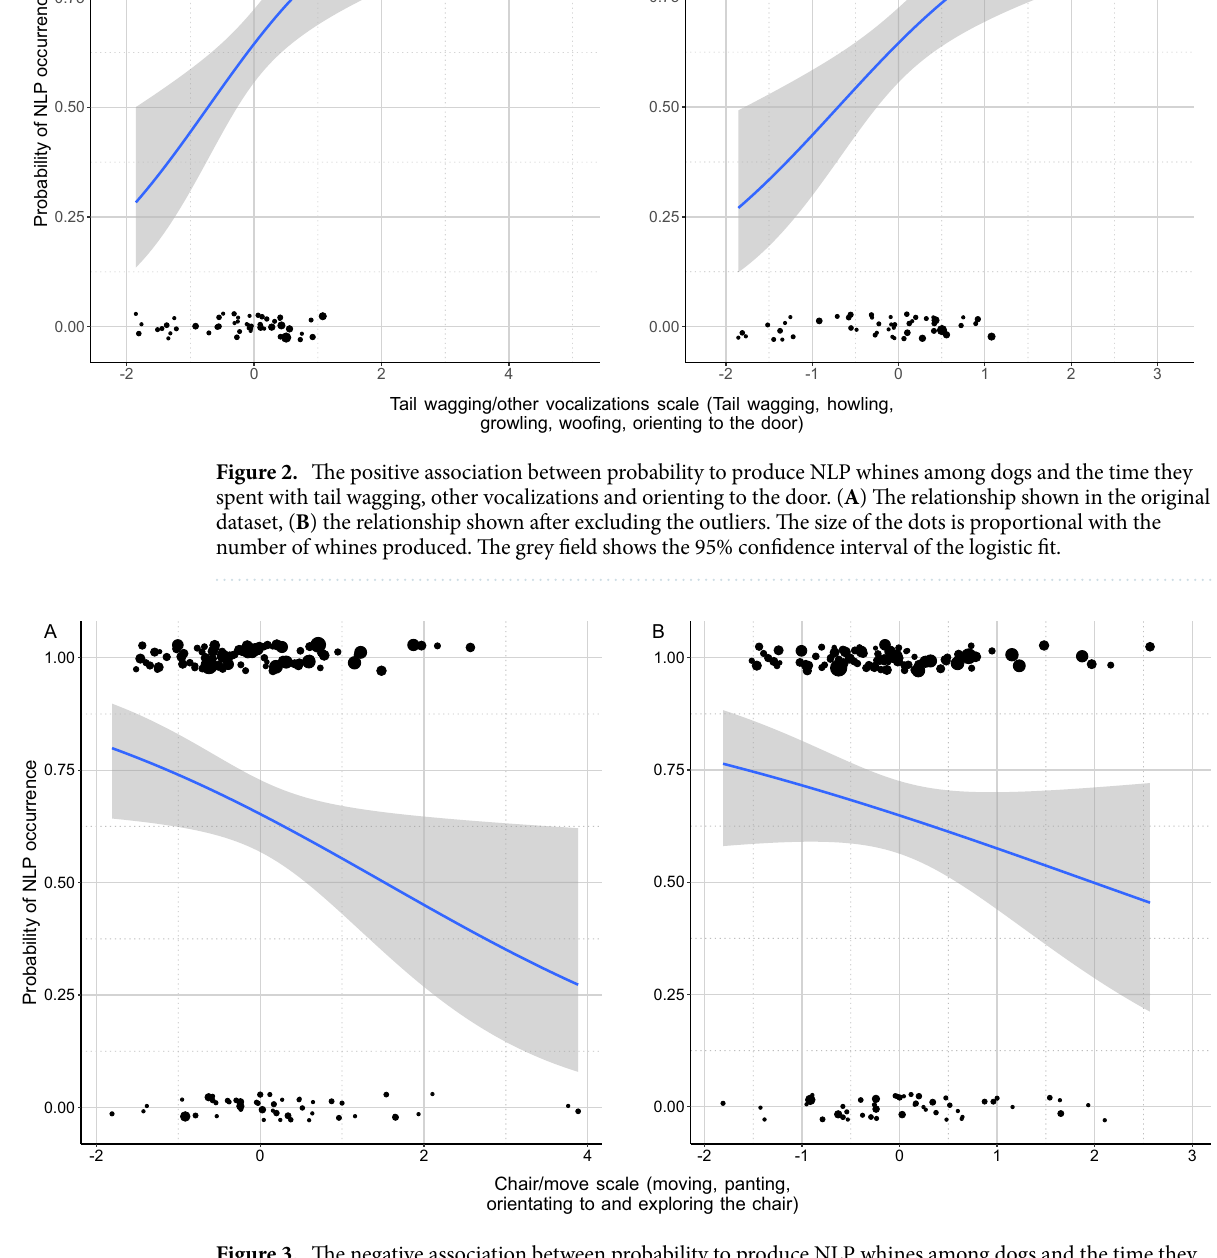
Figure 3. The negative association between probability to produce NLP whines among dogs and the time they spent with moving panting and chair directed behaviours. ( A ) The relationship shown in the original dataset, ( B ) The relationship shown after excluding the outliers. The size of the dots is proportional with the number of whines produced. The grey field shows the 95% confidence interval of the logistic